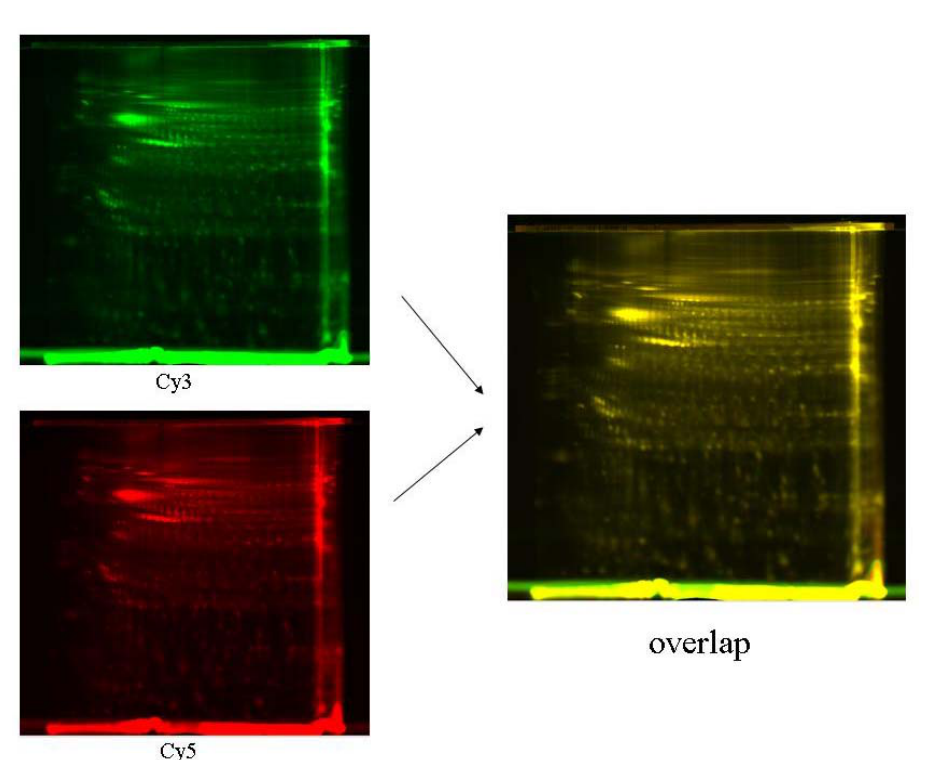
Figure 4. 2D protein patterns of 5 µg of protein extracts from mouse brain stained by saturation labeling–DIGE, focused on pI 4–7 range, separated on gels covering the 15–150 kDa